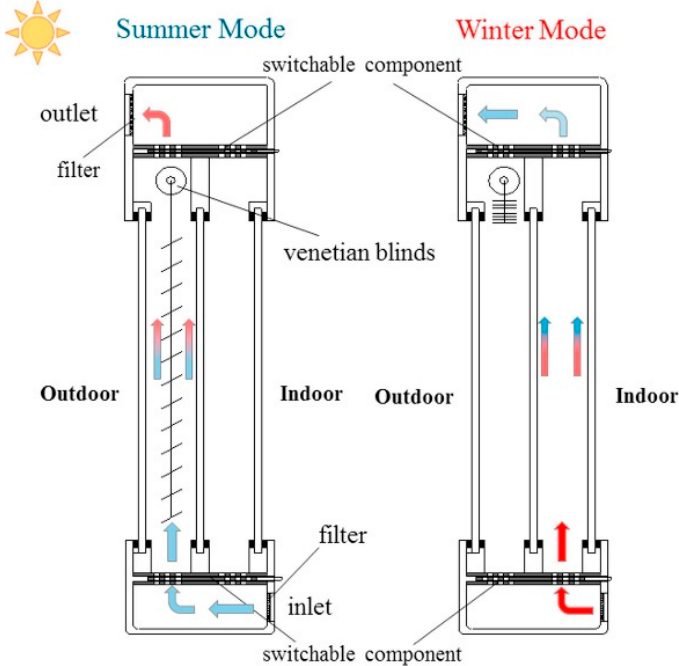
Figure 26. Example of blind position and air flow in winter and summer modes [88]. Table 7. Summary of shading systems (without